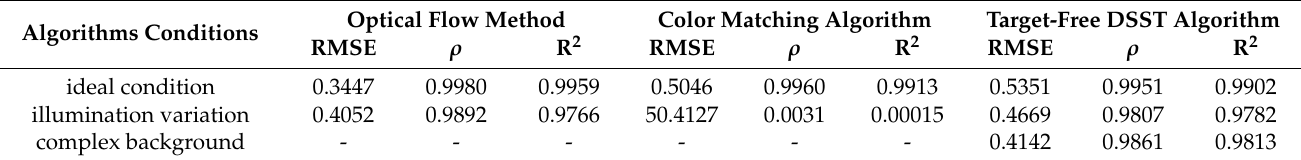
Table 1. Displacement time history and frequency domain error of different algorithms under different engineering